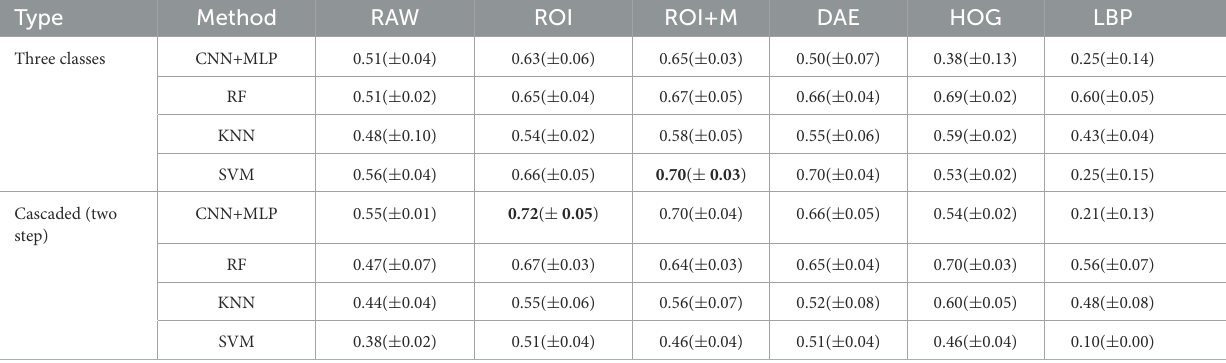
TABLE 2 Results from preliminary experiments on collateral flow